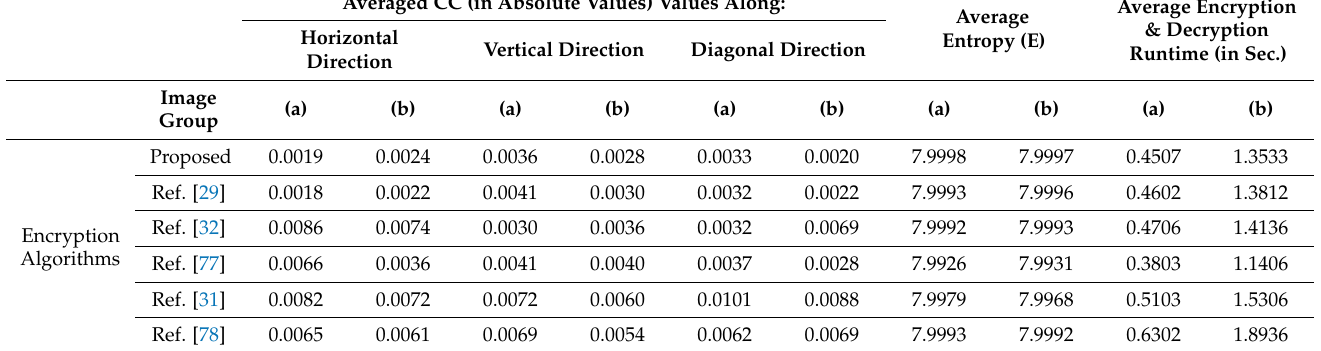
Figure 22. Test ( a ) grayscale and ( b ) color test images of size 512 × 512. Table 4. Comparison results in terms of the average CC, entropy and encryption/decryption runtime for different encryption schemes including the proposed one.